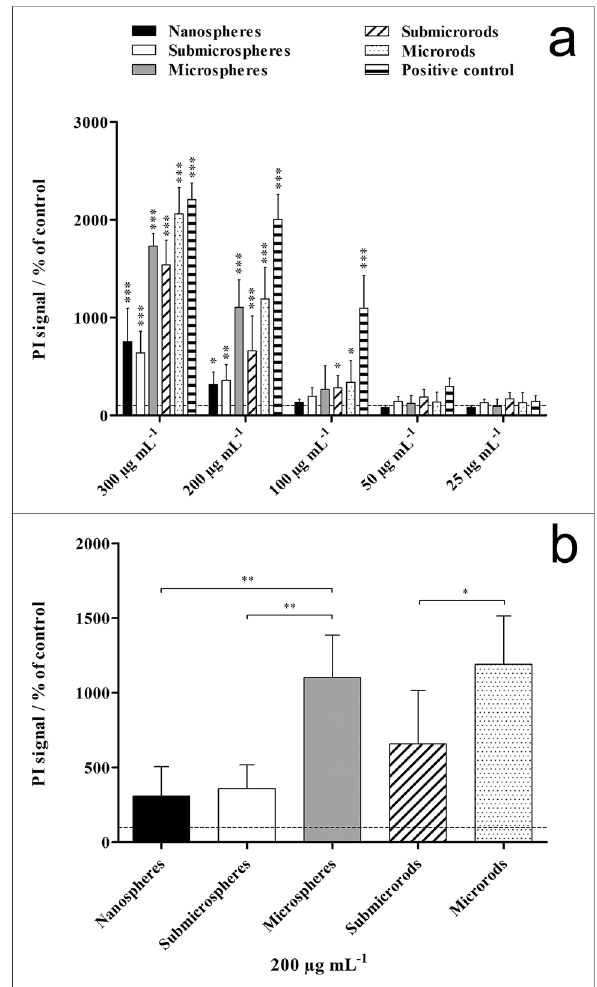
Figure 8. Viability of NR8383 alveolar macrophages after 16 h incubation with different unfunctionalized silica particles. The cell viability was determined by propidium iodide (PI) staining of non-viable cells and mean PI fluorescence intensity assessment by flow cytometry. Commercial silica particles served as positive control. ( a ) Comparison of the effects of different particle concentrations and morphologies on the cell viability. ( b ) Comparison of the effects of different particle morphologies on the cell viability at a particle concentration of 200 µg mL −1 . Data are expressed as mean ± SD ( n = 3), given as percentage of the control (100%, untreated cells). Asterisks (*) indicate significant differences in comparison to the control (** p < 0.01, *** p <